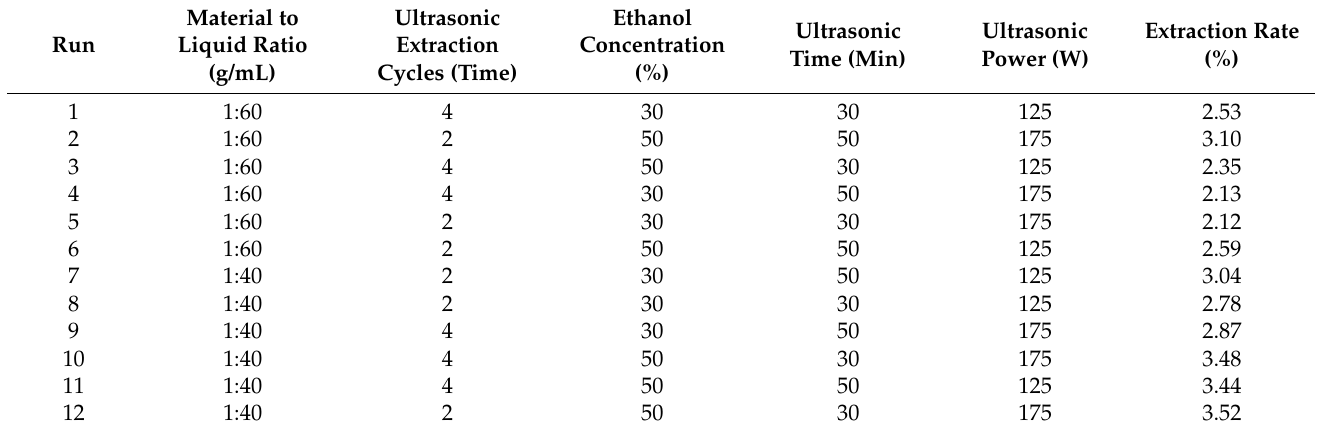
Table 1. Plackett-Burman experimental design and response values.